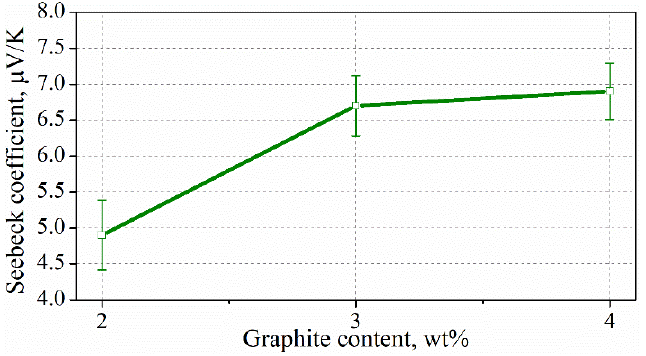
Figure 14. Seebeck coefficient of cement composites with exfoliated graphite.